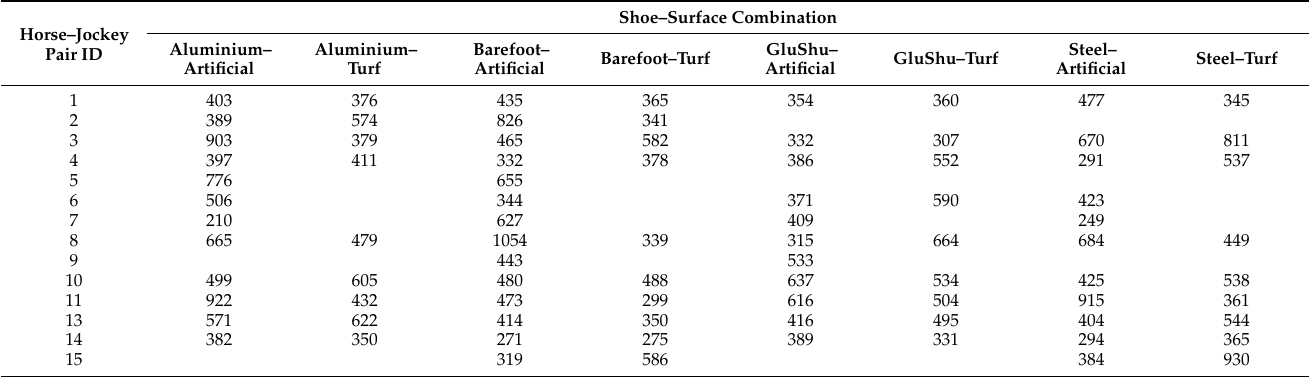
Table 1. Number of strides analysed per shoe–surface combination for each horse–jockey pair. Please note that the horse–jockey ID numbers are consistent with References